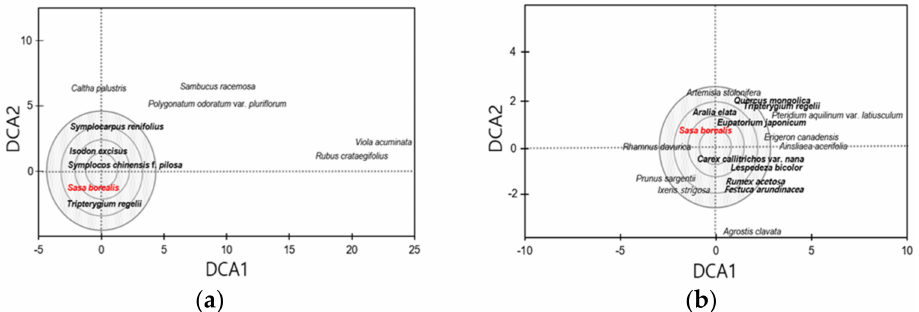
Figure 6. Detrended correspondence analysis (DCA). Plants that frequently appeared in the research area are shown on the graph, i.e., plants that appeared more frequently approach the center of the circle of the graph. ( a ) 2014; there were five species of plants that frequently appeared before grasslands were formed in the research area: Symplocarpus renifolius , Isodon excisus , Symplocos chinensis f. pilosa , Sasa borealis , and Tripterygium regelii . ( b ) 2019; the number of taxa increased compared to 2014 from 10 to 16, with five species increasing inside the target. The number of Sasa borealis increased, and the plants with increased cover were Aralia elata , Carex callitrichos var. nana , Eupatorium japonicum , Festuca arundinacea , Lespedeza bicolor , Quercus mongolica , Rumex acetosa , and Tripterygium regelii